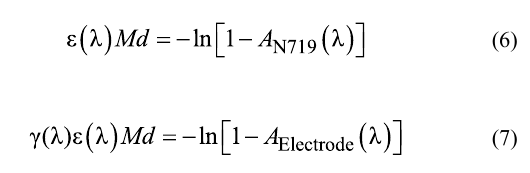
absorbed light fraction in the dye of the sensitized PA is tional indetermination of 4% in the measured T ( λ ) values is